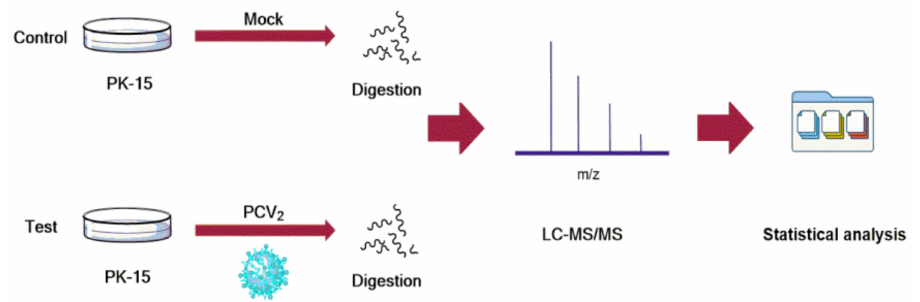
Figure 1. Experimental